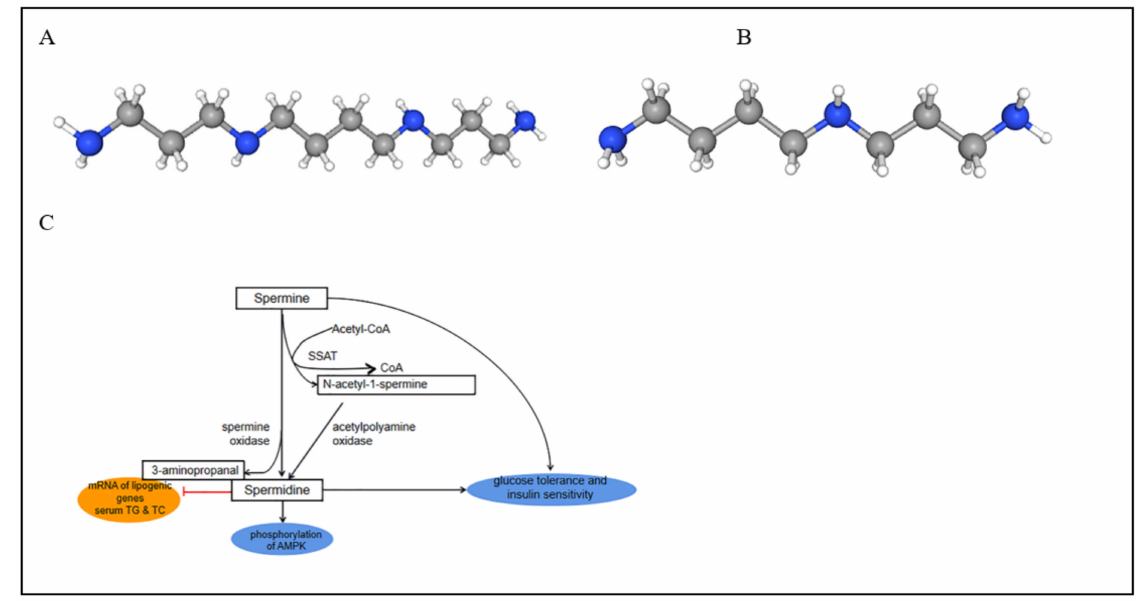
Figure 6. Molecular structure of spermine ( A ) and spermidine ( B ). : N, C, H, and their metabolic pathways ( C